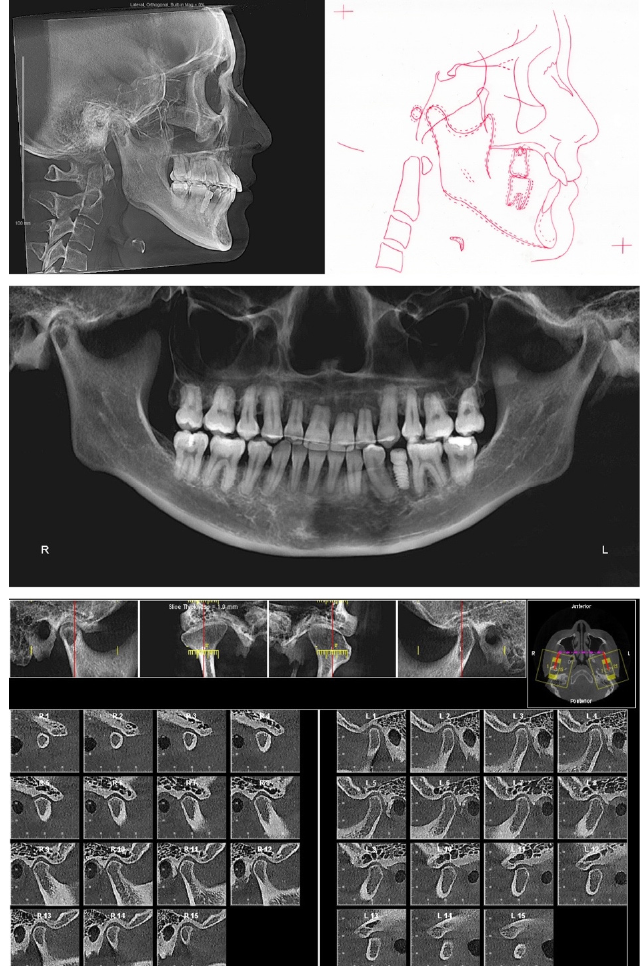
Diagnostics 2022 , 12 , 1055 Figure 10. Posttreatment radiographs and cephalometric tracing. Figure 10. Posttreatment radiographs and cephalometric tracing.